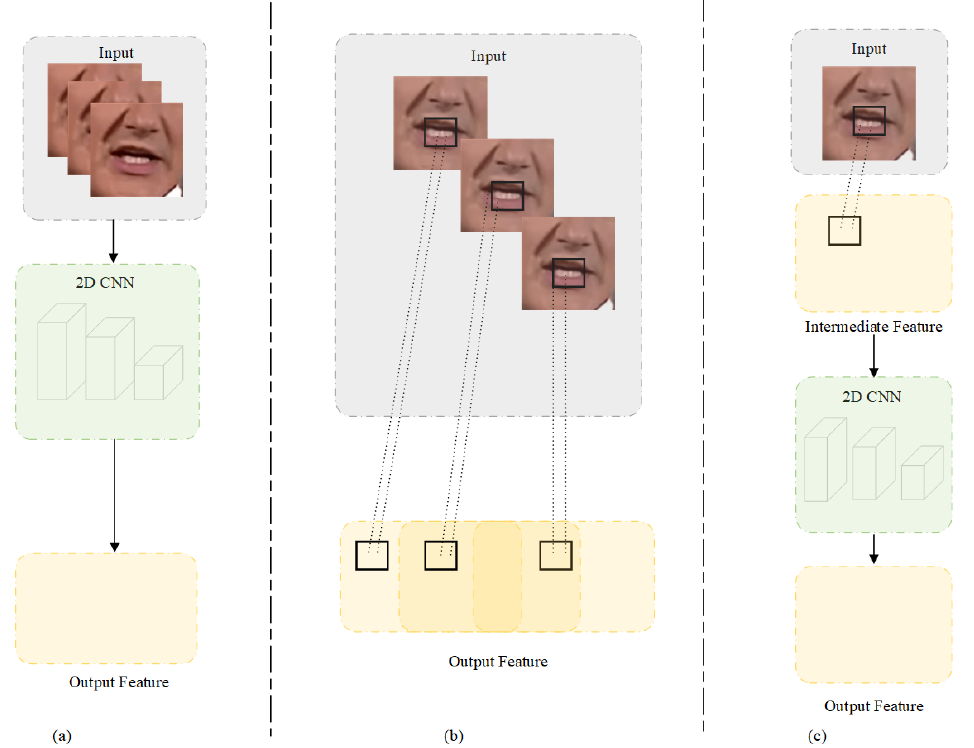
Figure 3. Visual feature extraction structure base CNN. ( a ) Base 2D CNN lip recognition models. ( b ) Base 3D CNN lip recognition models. ( c ) Base 3D + 2D CNN lip recognition